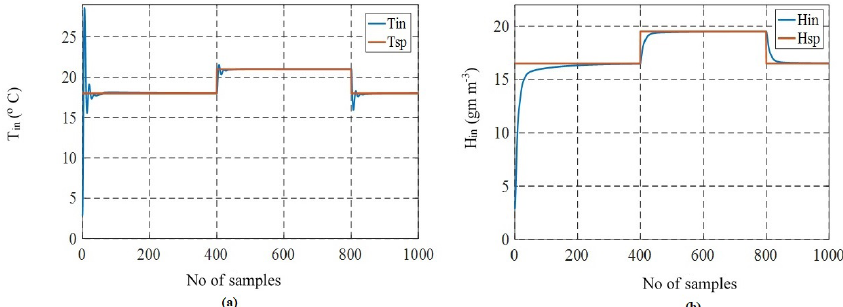
Figure 14. (a) Closed-Loop Response of Inlet Temperature T in for Step Changes in Temperature with PI Controller and (b) Closed-Loop Response of Inlet Humidity H in for Step Changes in Humidity with PI Controller.